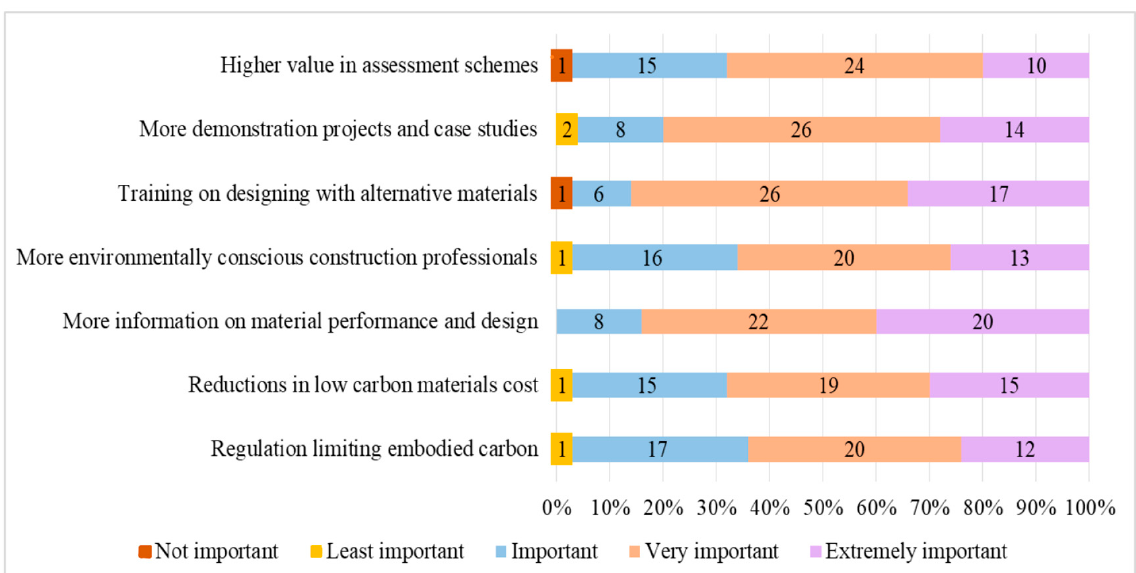
Figure 3. Future factors encouraging the use of alternative